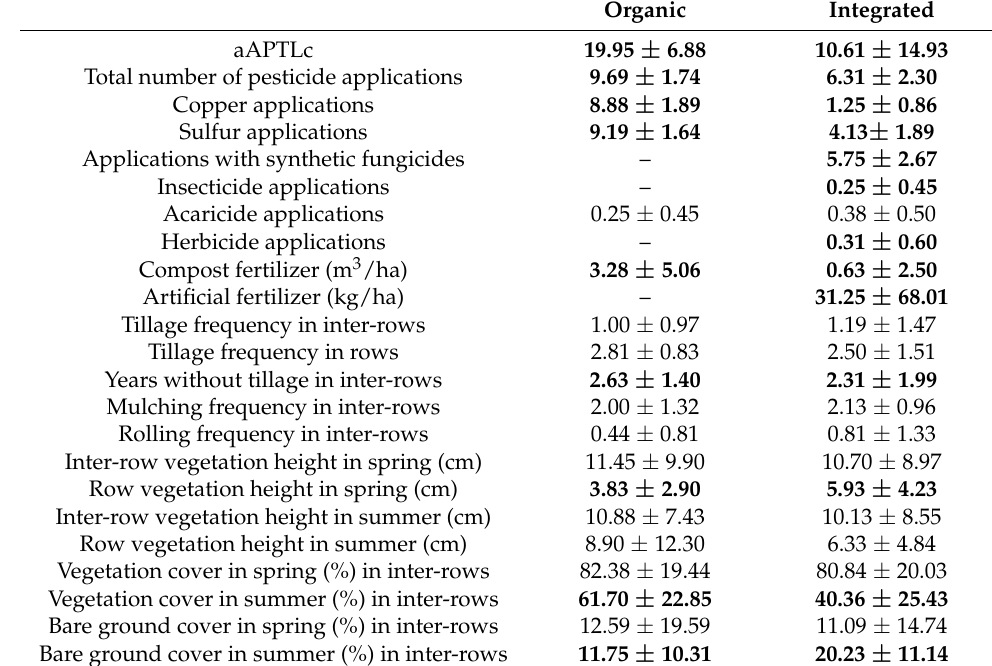
Table 1. Treatment variables of organic and integrated vineyards (mean ± standard deviation). Bold numbers display variables that are significantly different between organic and integrated management. aAPTLc = area-related acute pesticide toxicity contact load. Tillage frequency differed in neighboring inter-rows; therefore, management measures are displayed for the inter-row in which vegetation data were collected in spring and